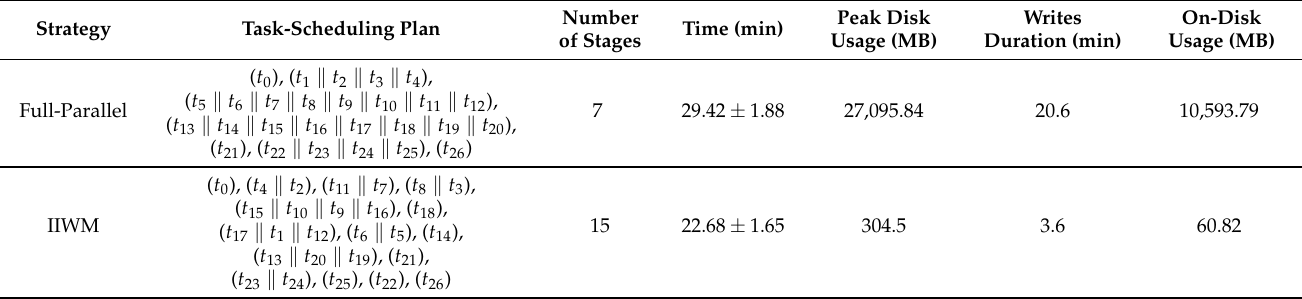
Table 12. Scheduling plan and statistics about execution times and disk usage with 9.5 GB of RAM. Strategy Task-Scheduling